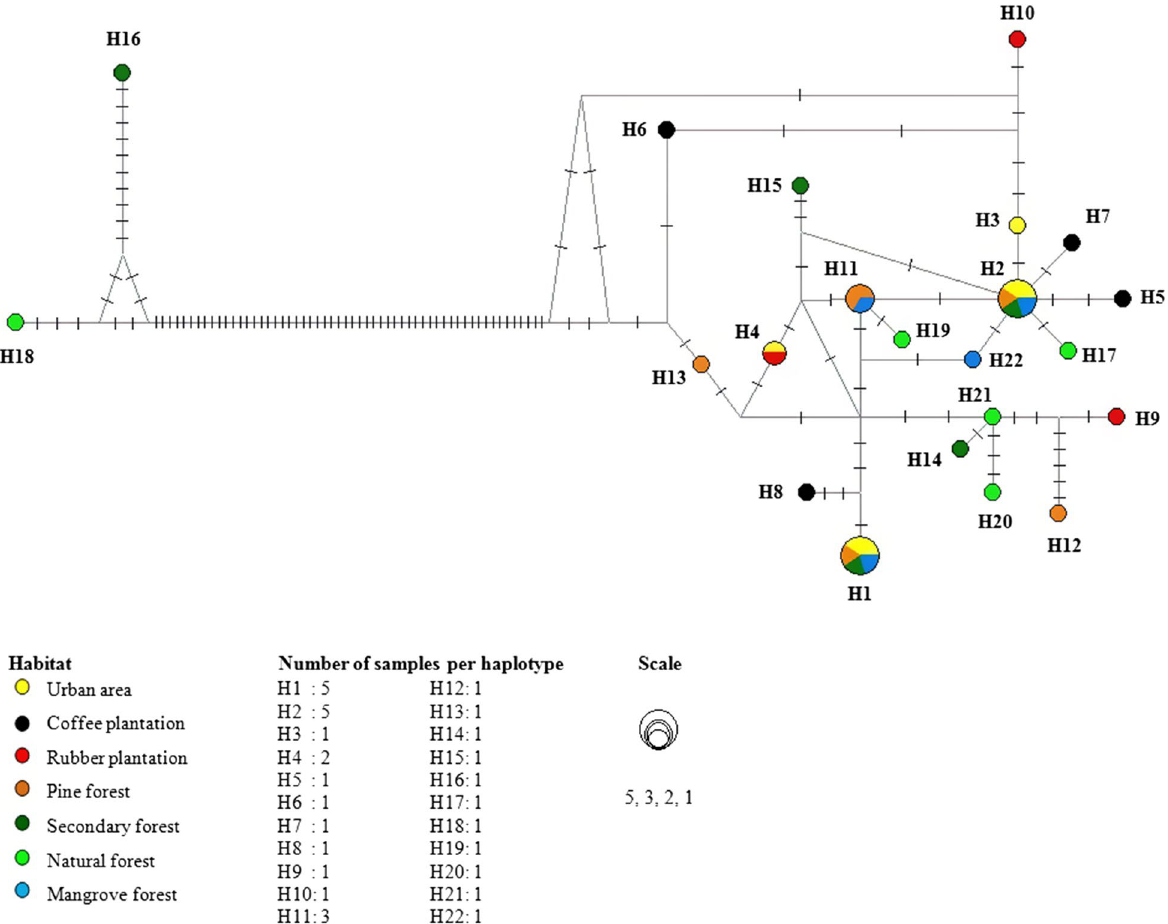
Fig. 3 Haplotype network of Cynopterus brachyotis from seven habitats on Java island based on 333 bp mitochondrial DNA D-loop